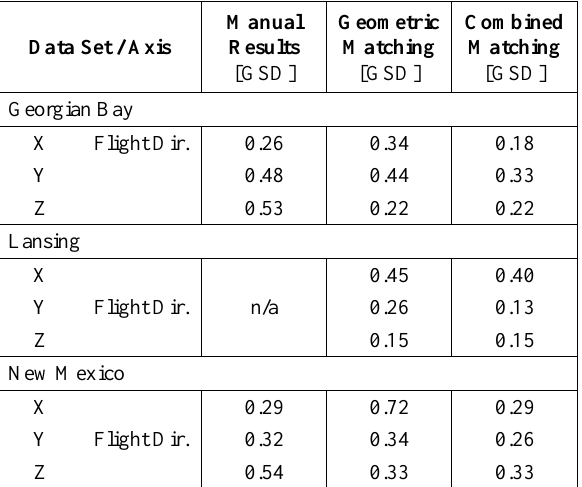
Table 3. Offset standard deviations throughout strip overlaps, for Lansing and Georgian Bay RMS values based on all over- laps. The number of manual measurements per overlap in Lan- sing varies between 3 and 5, which is not representative for the derivation of reliable